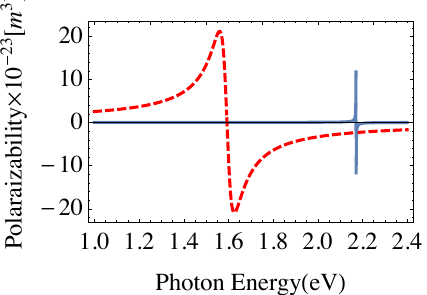
Figure 3. The real part of polarizability induced by x-polarized probe field for; (solid) GND of L z = 7 nm and L x = 0.5 nm with Fermi energy of 1.36 eV, temperature of 300 K and carrier’s mobility of 10 4 cm 2 /Vs, and for; (dashed) MNP of radius R M = 15 nm, (cid:101) ∞ = 5.7, ω p = 1.36 × 10 16 s − 1 and damping of γ M = 10 14 s − 1 . The plasmonic components are embedded in GaAs.